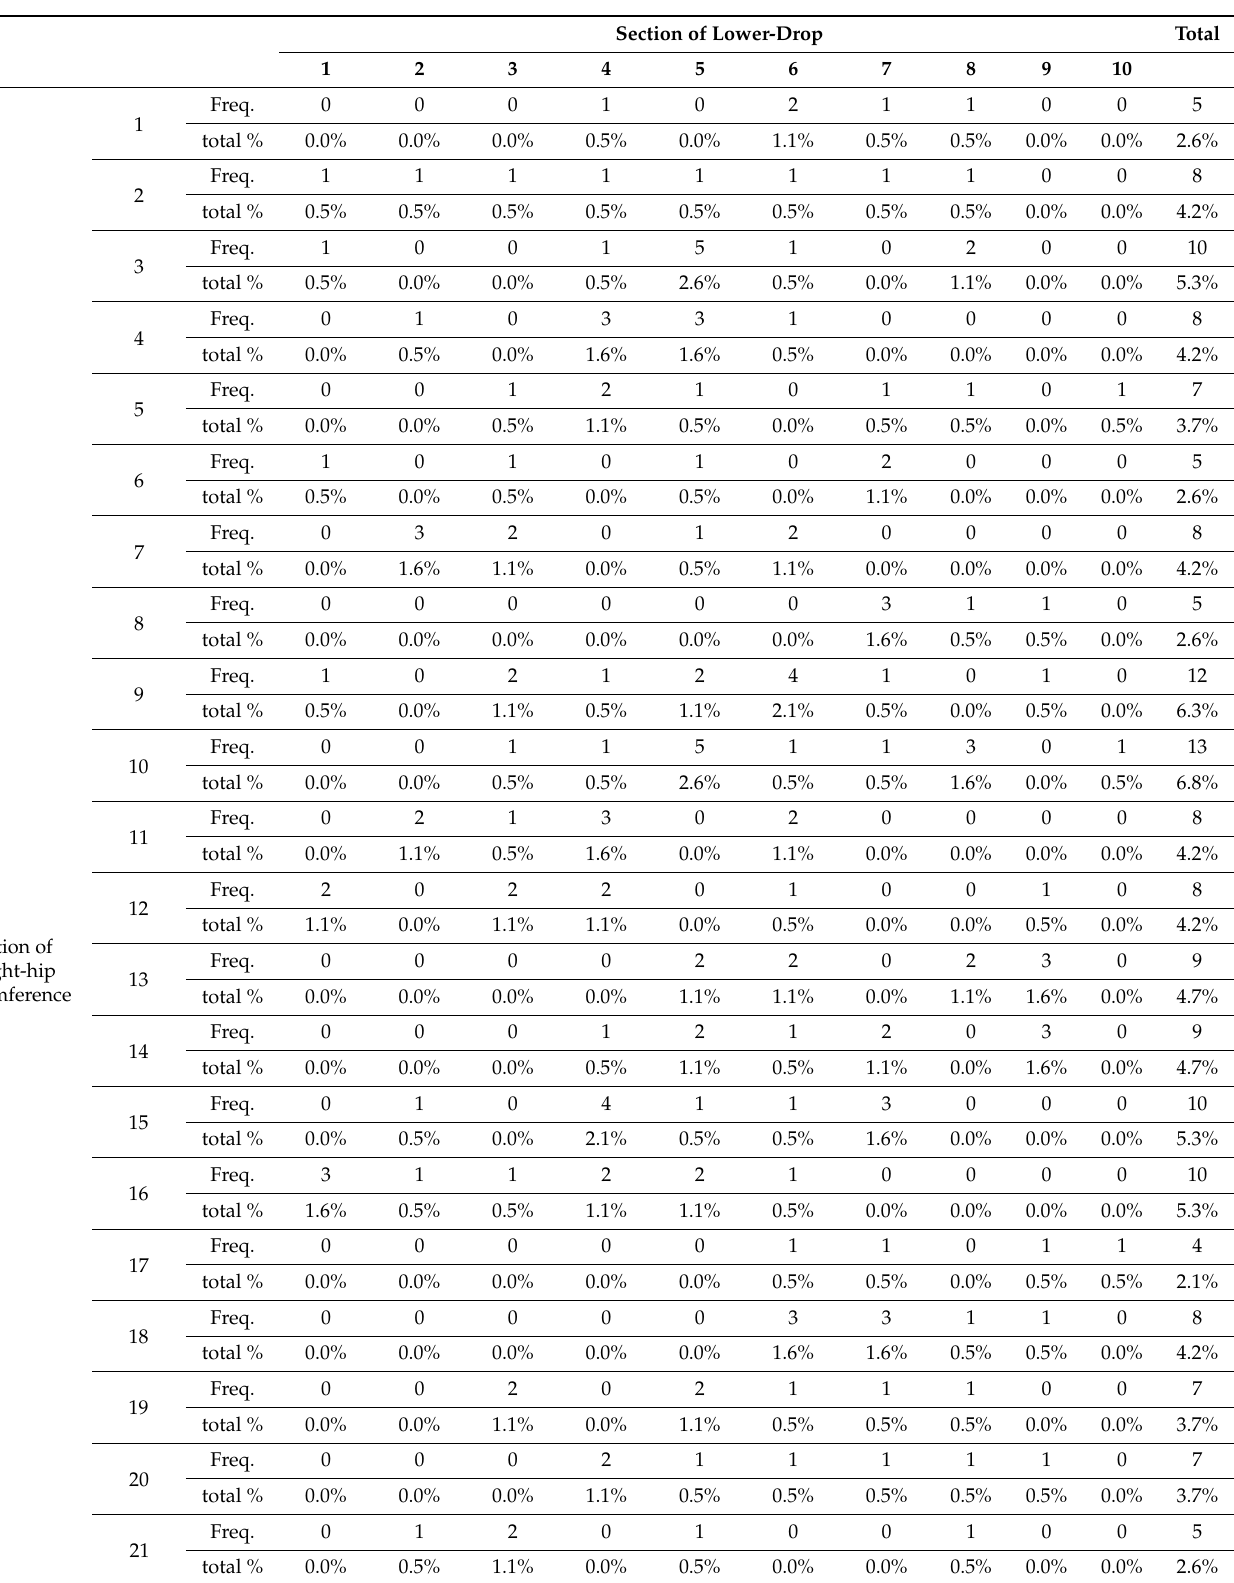
Table 7. Results of secondary cross-tabulation